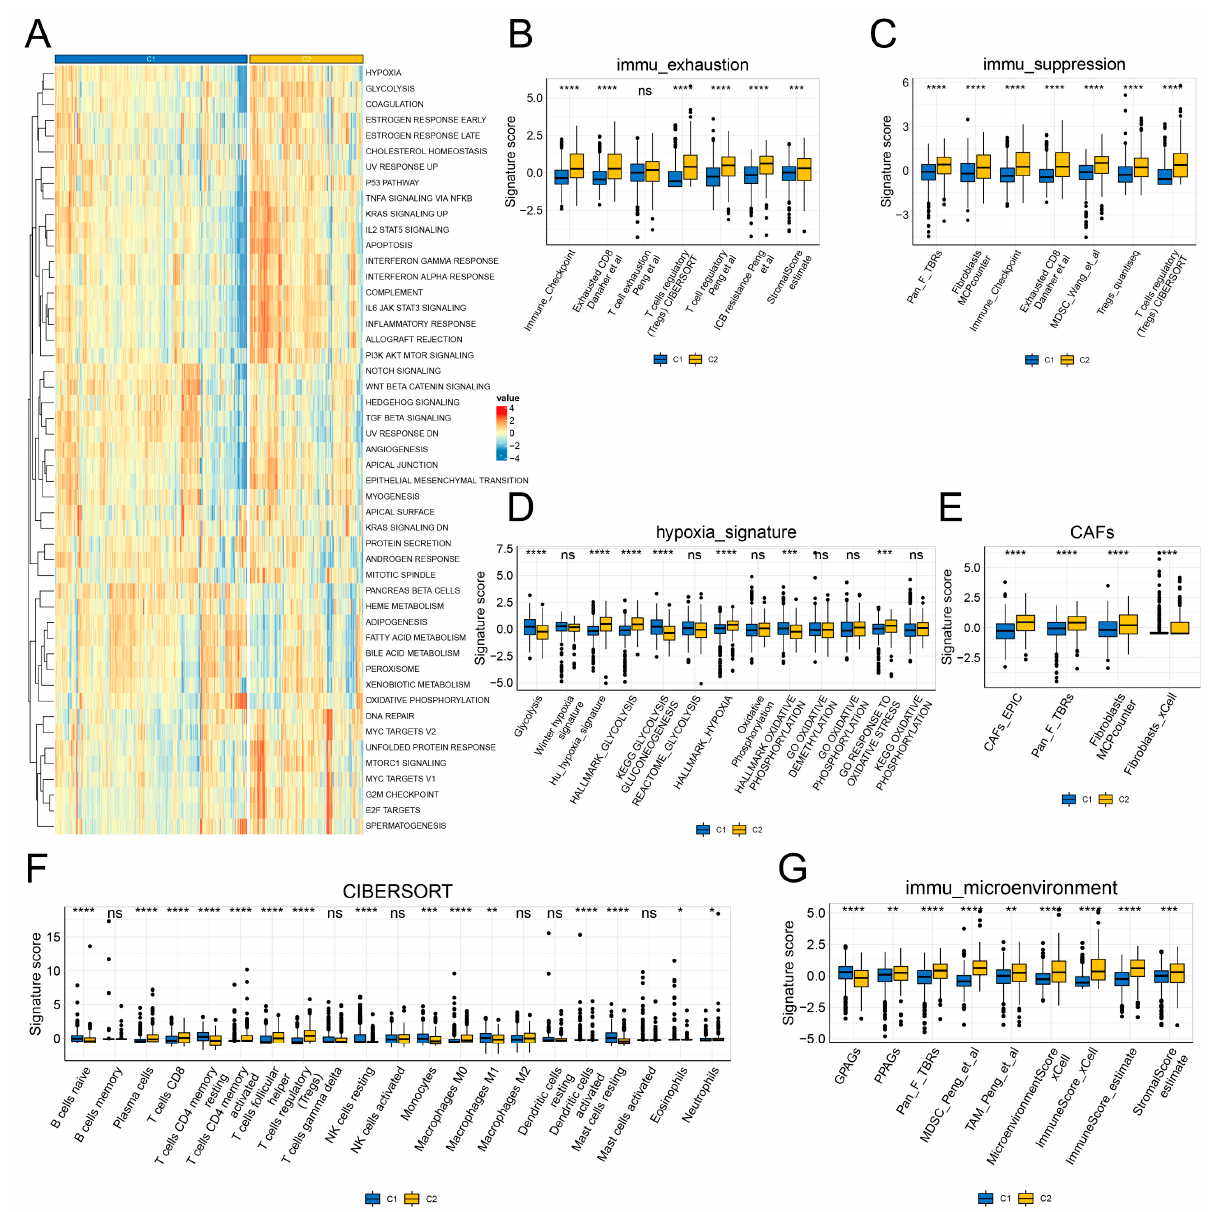
Figure 3. Immune characteristics of the two inflammation clusters. ( A ) Cancer hallmarks of the two inflammation clusters. ( B ) Immune exhaustion signature of the two inflammation clusters. ( C ) Immune suppression signature of the two inflammation clusters. ( D ) Hypoxia signature of the two inflammation clusters. ( E ) CAFs signature of the two inflammation clusters. ( F ) Infiltration levels of immune cells between the two inflammation clusters were estimated using the CIBERSORT algorithm. ( G ) Immune microenvironment signature of the two inflammation clusters. * p < 0.05; ** p < 0.01; *** p < 0.001; and **** p <